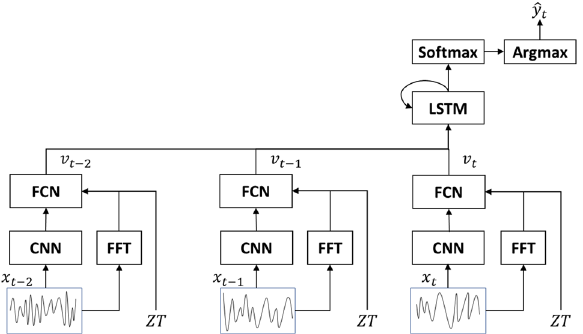
Figure 2. UTSN-L architecture. The signal from each epoch is processed using the same architecture as the UTSN until the FCN (i.e., before the final softmax function). x t , x t − 1 , … x t − m + 1 are EEG signals for epochs t to t − m + 1 , respectively. The output of the FCN is a sequence of low dimensional feature vectors, v t , v t − 1 , … v t − m + 1 , which is sent to the LSTM. ˆ y t is the final output that predicts the sleep stage for epoch t . The diagram shows a case in which m = 3 ( m = 10 in the real implementation).